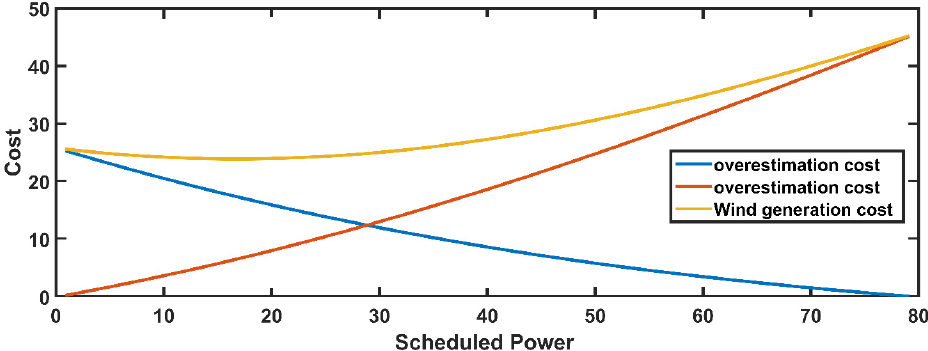
Figure 10. Wind generation cost versus scheduled power from 80 MW wind farm.